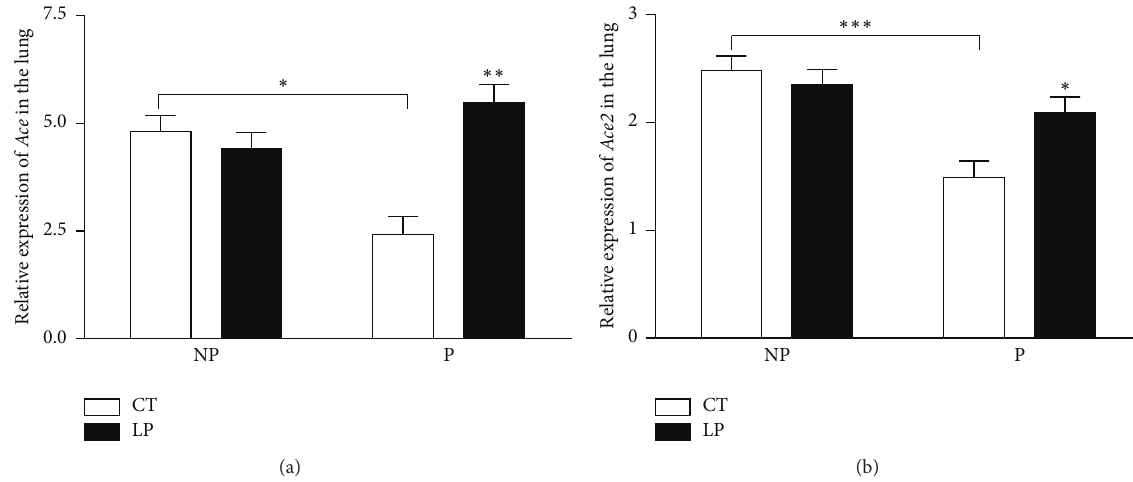
Figure 7: Quantitative real-time PCR analysis of Ace (a) and Ace2 (b) in the lung of nonpregnant and pregnant rats fed a low-protein diet. CT: control; LP: low protein; NP: nonpregnant rats fed either CT or LP diet for 17 days; P: pregnant rats fed either CT or LP diet for 17 days. The error bar represents the mean ± SEM expressed as relative units of mRNA standardized against R18s ( 𝑛 = 5 - 6 rats/diet group/day). ∗ 𝑃 < 0.05 ; ∗∗ 𝑃 < 0.01 ; ∗∗∗ 𝑃 < 0.001